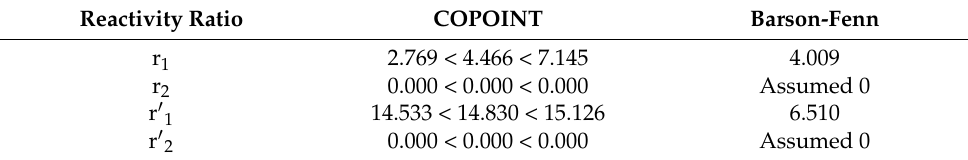
Table 5. Reactivity Ratios for the PNVP-stat-PIBMA copolymers synthesized via RAFT. Reactivity Ratio